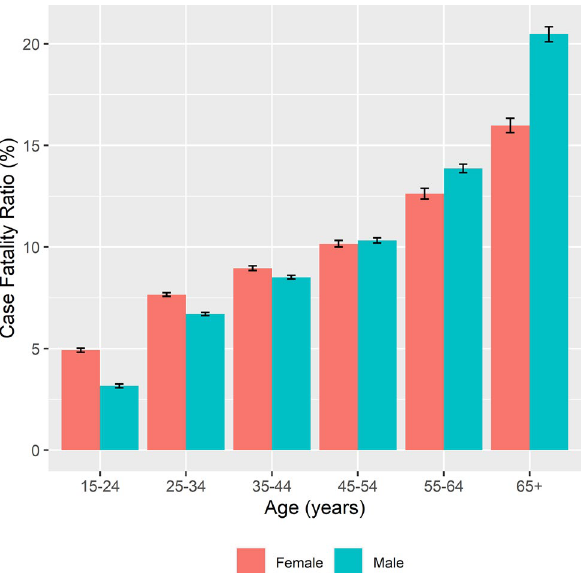
Figure 2. Case fatality ratio of adults (≥ 15 years) on drug-susceptible tuberculosis treatment by age category and sex for the combined period 2009–2016, South Africa. Case fatality ratio is calculated as percentage of deaths among all those with TB, regardless of known or unknown